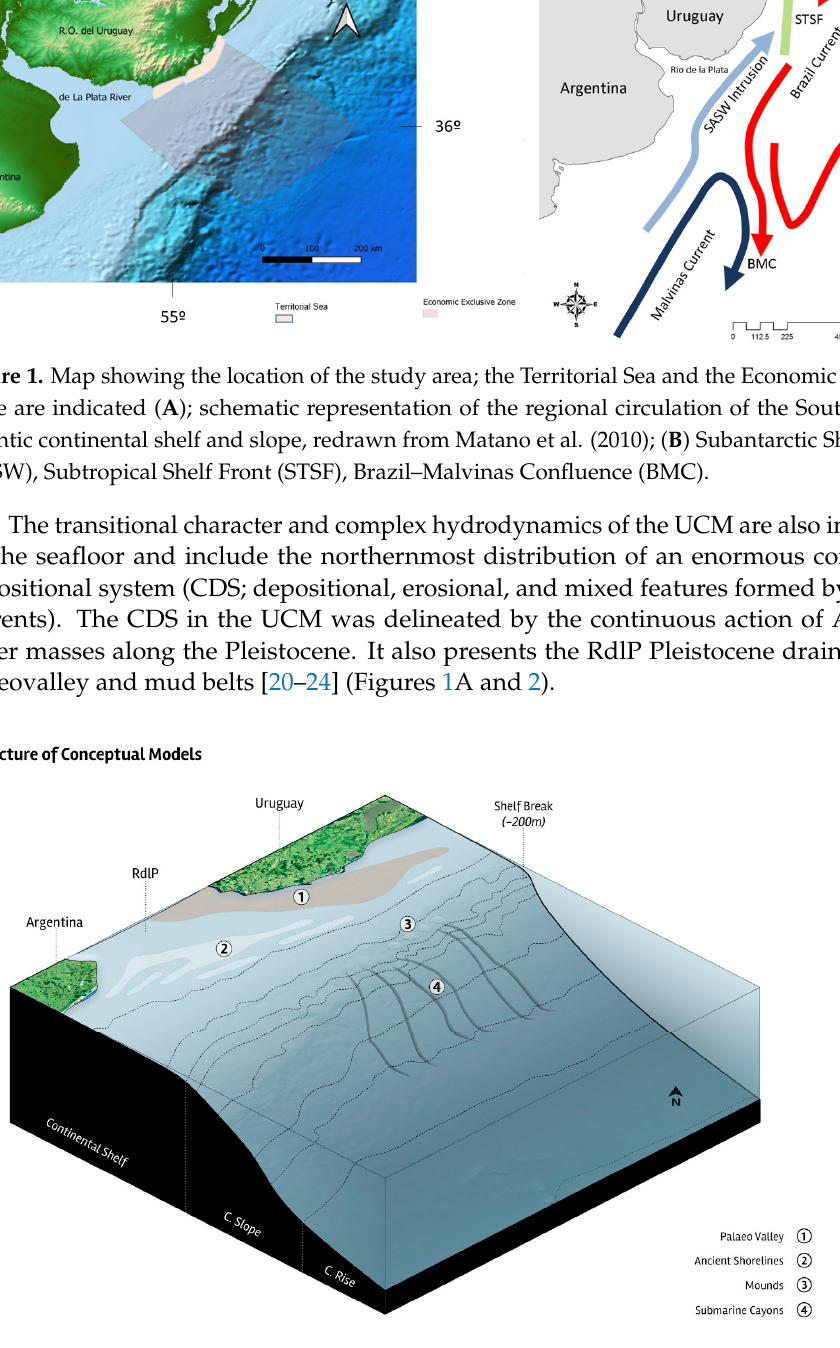
Figure 2. Schematic representation of the horizontal subdivision (subsystems) of the continental margin showing general geomorphological characteristics.